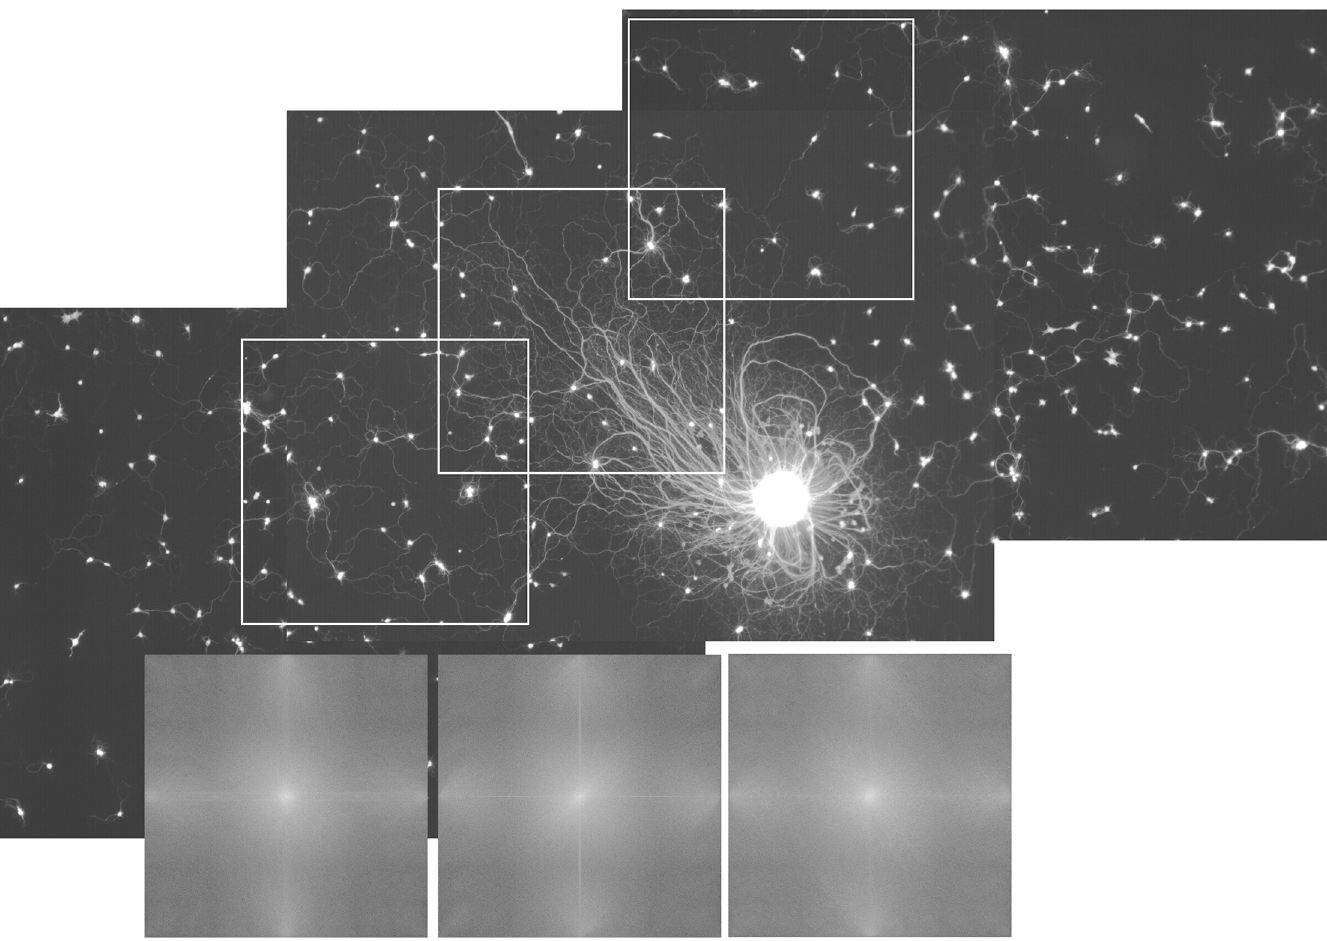
Fig 10. A sympathetic explant with asymmetric outgrowth. The longest neurites of the explant extend towards the upper left of the field contained in the middle box. This explant was co-cultured with dissociated neurons, which show no consistent orientation in outgrowth. The insets show Fourier transforms of the three respective white-bordered subfields showing that only the explant halo shows outgrowth in predominantly one direction [indicated by the bright line extending from the lower left to the upper right quadrant in the middle transform].